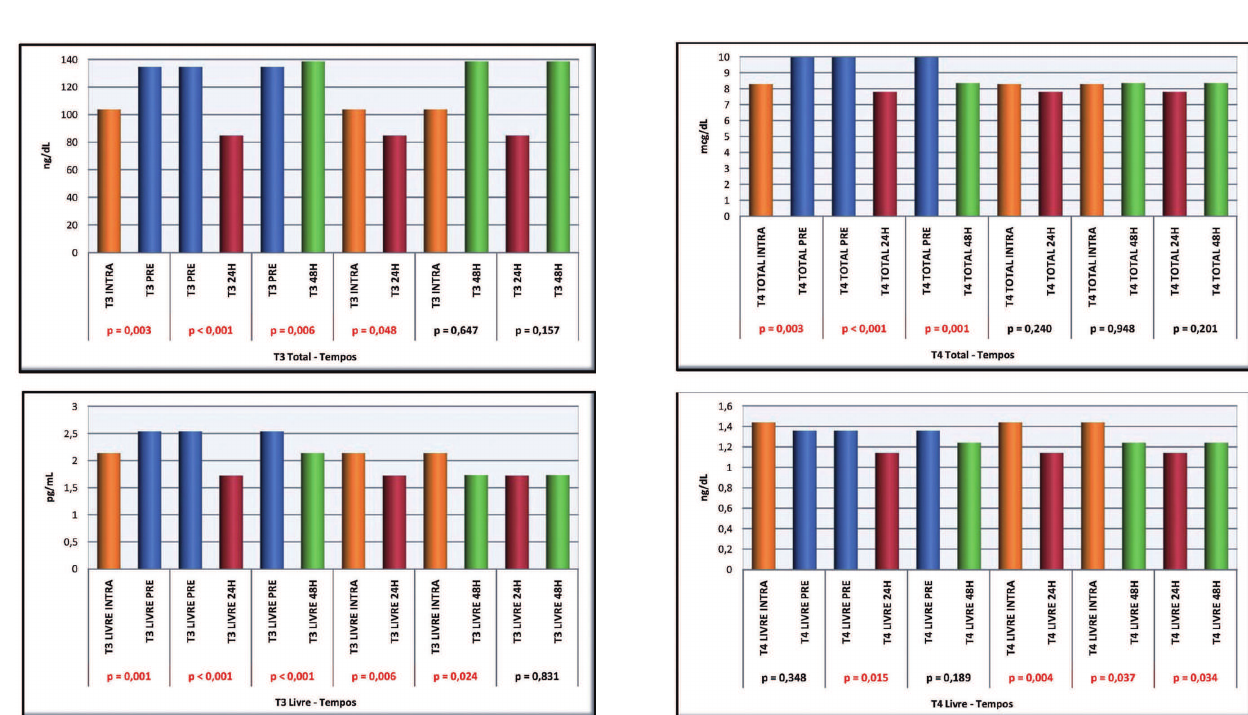
Fig. 3 – Comparação concomitante entre os momentos de observação para T3 total e T3